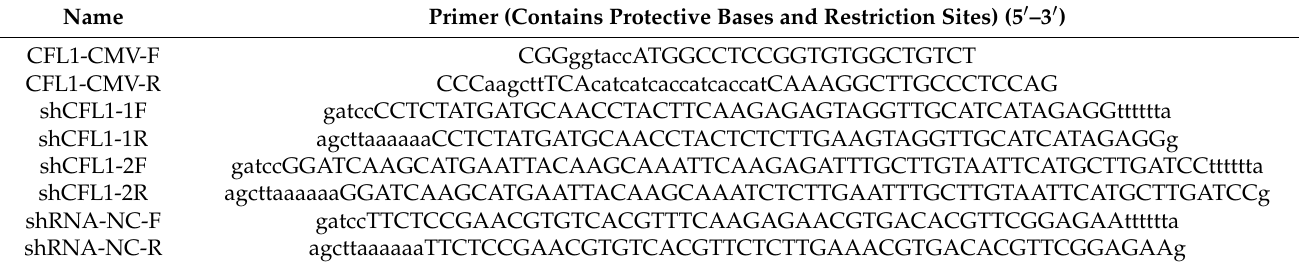
Table 1. Primer information for vector construction.